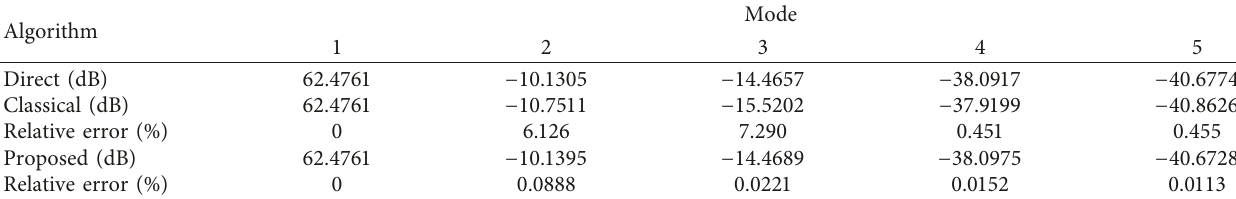
Table 2: Comparison of resonance responses between different CMS